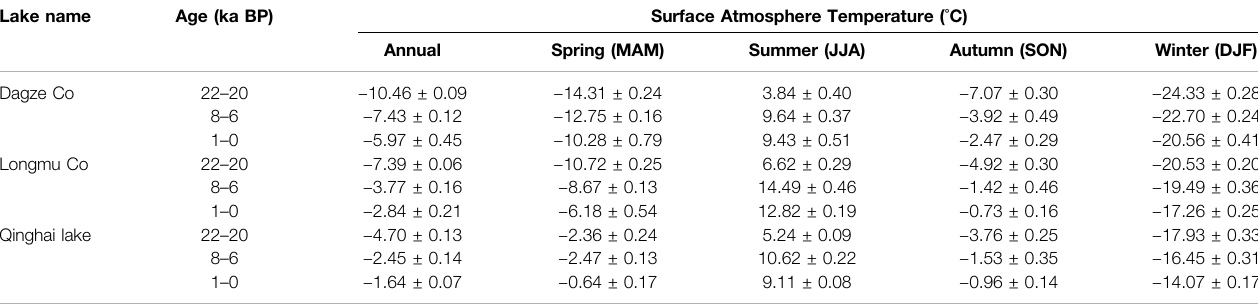
TABLE3| SimulatedannualandseasonalsurfaceatmospheretemperaturesbasedontheTraCE-21model.Thedataweredownloadedfromwebpagehttp://202.195.239. 65:8888/, then